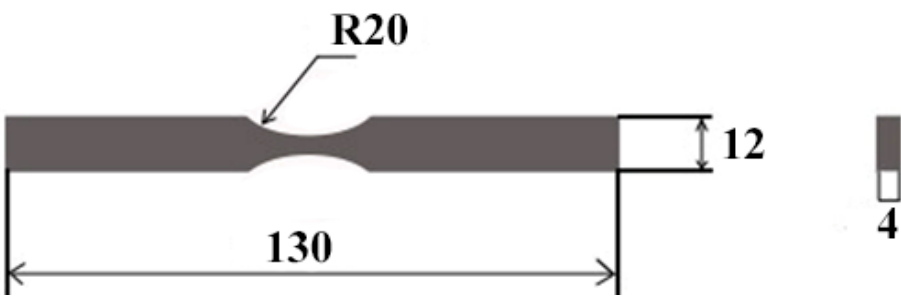
Figure 1. Dimensions of the VT1-0 titanium sample used for the fatigue tests. (unit: mm).